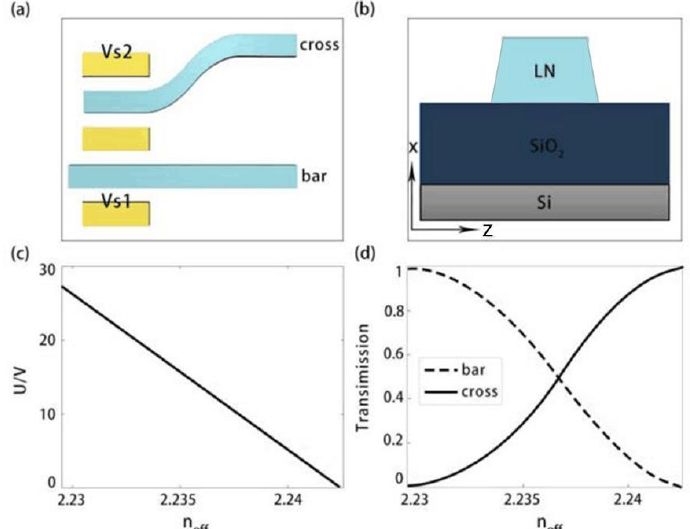
Figure 3. ( a ) The structural diagram of the LiNbO 3 directional coupler; ( b ) cross-section view of the directional coupler; ( c ) change of the required external voltage versus the effective mode index of LiNbO 3 waveguide; ( d ) the transmission of the cross (solid) and bar (dashed) end of the directional coupler versus the effective mode index.